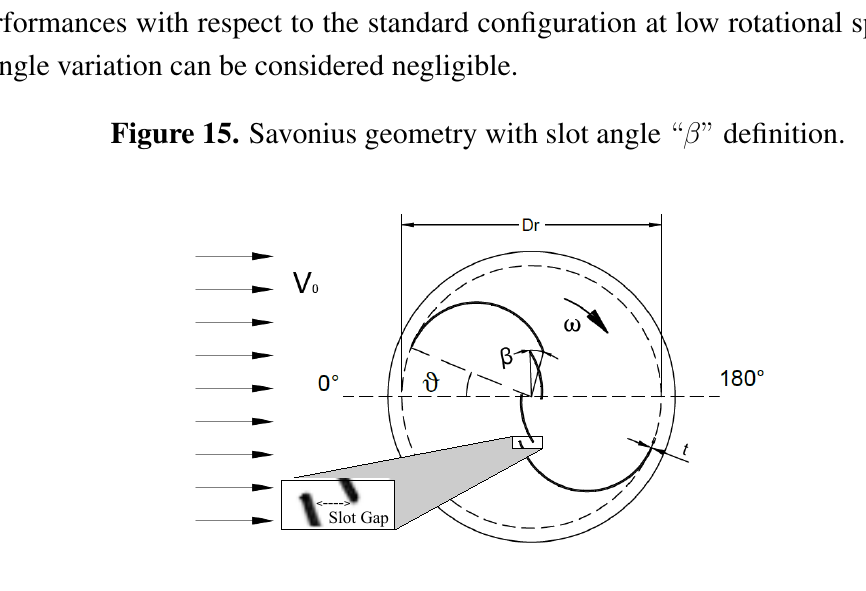
Figure 16. ( a ) Averaged C Av